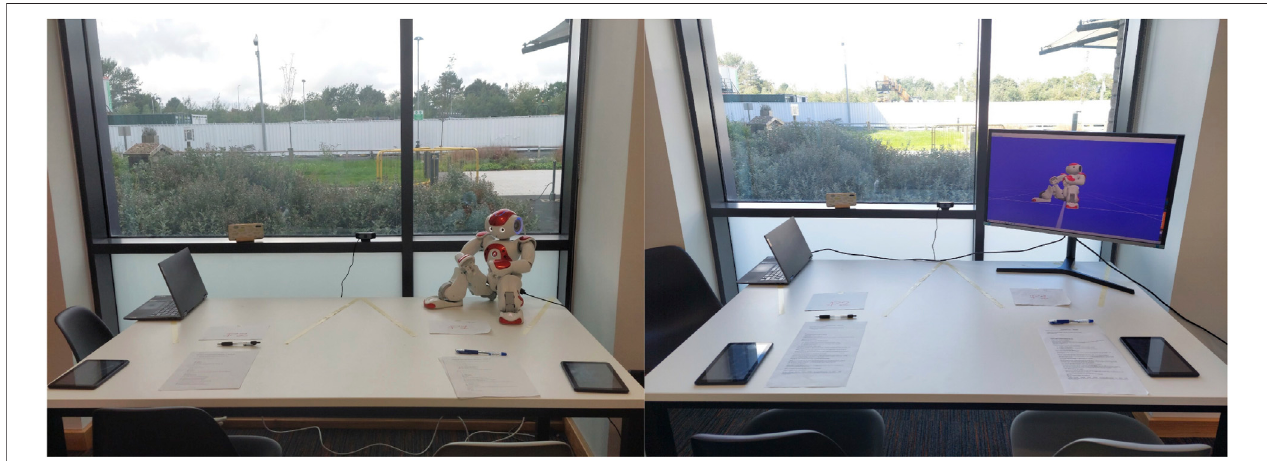
FIGURE 3 | The setup was consistent for both physical robot and virtual robot conditions; only the type of invigilator is changed.